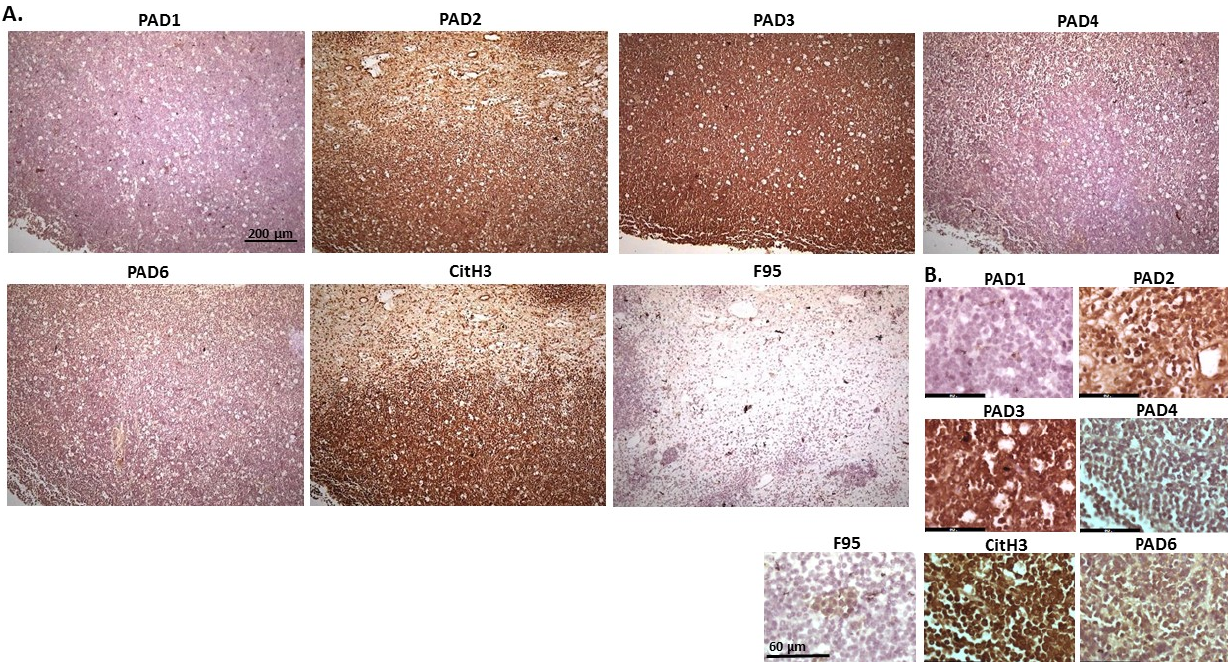
Figure 10. Pig, lymphoma (lymph node and kidney). ( A ) Overview images for PAD1, 2, 3, 4, 6, CitH3 and F95 stainings of serial tissue sections; scale bar represents 200 µ m for all images; 10 × objective. ( B ) Higher magnification shown for each staining from the images in ( A ); scale bar represents 60 µ m for all images; 40 × objective.